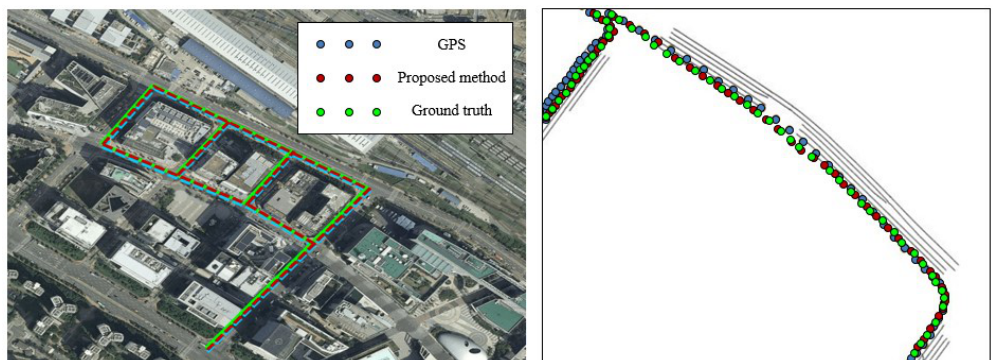
Figure 12. Results of localization in course 1.